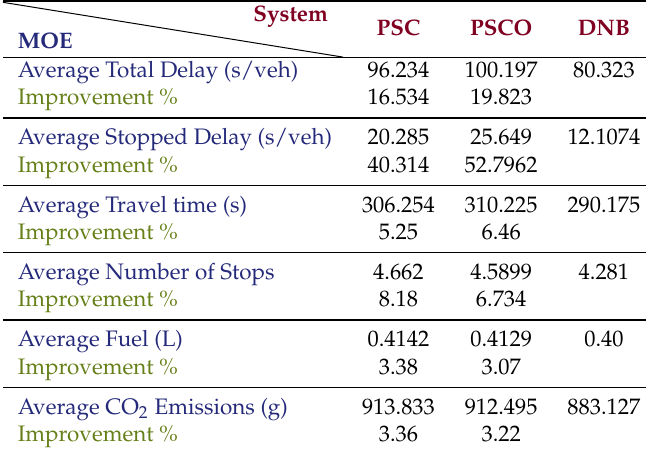
Table 4. Average measures of effectiveness (MOEs) and (%) improvement for game-theoretic framework (DNB) over phase split and cycle length controller (PSC) and phase split-cycle length and offset optimization controller (PSCO) controllers.